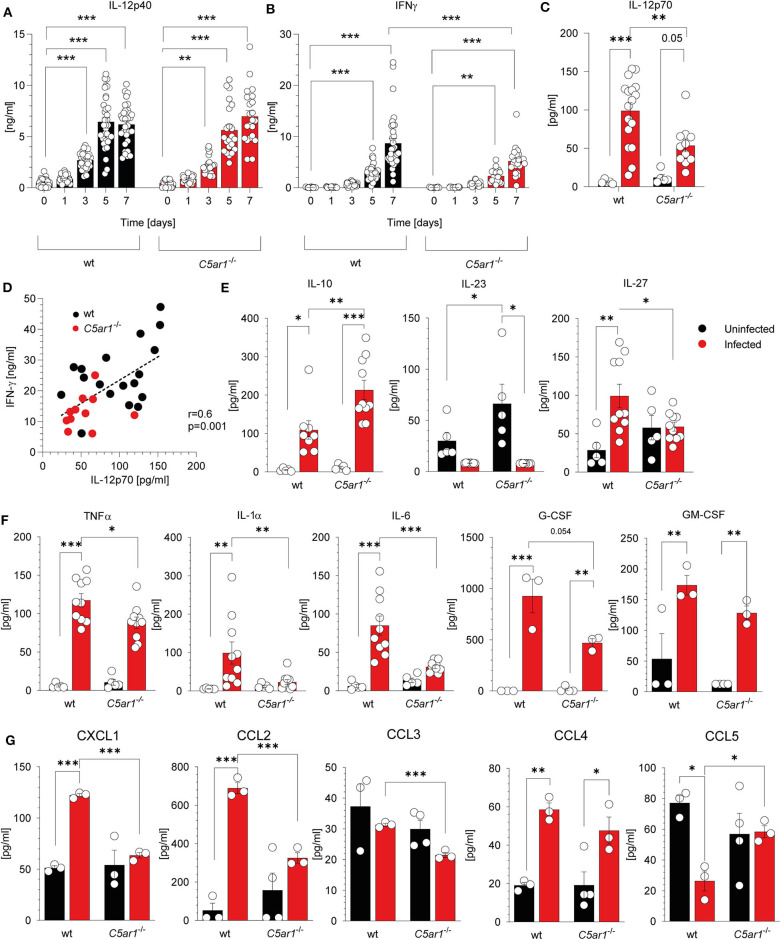
C5aR1 activation drives systemic cytokine and chemokine production during the early phase of T. gondii infection. (A) Kinetics of IL-12p40 and (B) IFN-γ serum concentrations in wt and C5ar1−/− mice after T. gondii infection. Serum samples were obtained before and 1, 3, 5, and 7 days after infection. Cytokine levels were determined by ELISA. The data are from three independent experiments, n = 22–33/condition. (C) IL-12p70 cytokine serum concentrations in wt and C5ar1−/− mice 7 days after T. gondii infection as determined by bioplex assay (Meso Scale Discovery); n = 10–17/condition. (D) Linear regression analysis between IL-12p70 and IFN-γ serum concentrations 7 days after infection. The p-value was calculated using the Pearson's correlation coefficient, n = 29 pairs. (E) IL-10, IL-23, and IL-27 cytokine serum concentrations in wt and C5ar1−/− mice 7 days after T. gondii infection; n = 10–17/condition. (F) Serum concentrations of TNF-α, IL-1α, IL-6, G-CSF, and GM-CSF determined in wt and C5ar1−/− mice 7 days after infection. Cytokine concentrations were determined by LEGENDplex™ assay (BioLegend), n = 10/group. (G) Serum concentrations of CXCL1 (KC), CCL2 (MCP-1), CCL3 (MIP-1α), CCL4 (MIP-1β), CCL5 (RANTES) in wt and C5ar1−/− mice 7 days after infection. The cytokines and chemokines were determined by Bio-Plex assay (Bio-Rad), n = 3/group. Values shown in (A–C) and (E–G) are the mean ± SEM, Differences between groups were determined by ANOVA and Sidak's post-hoc test. *p < 0.05, **p < 0.01, ***p < 0.001.